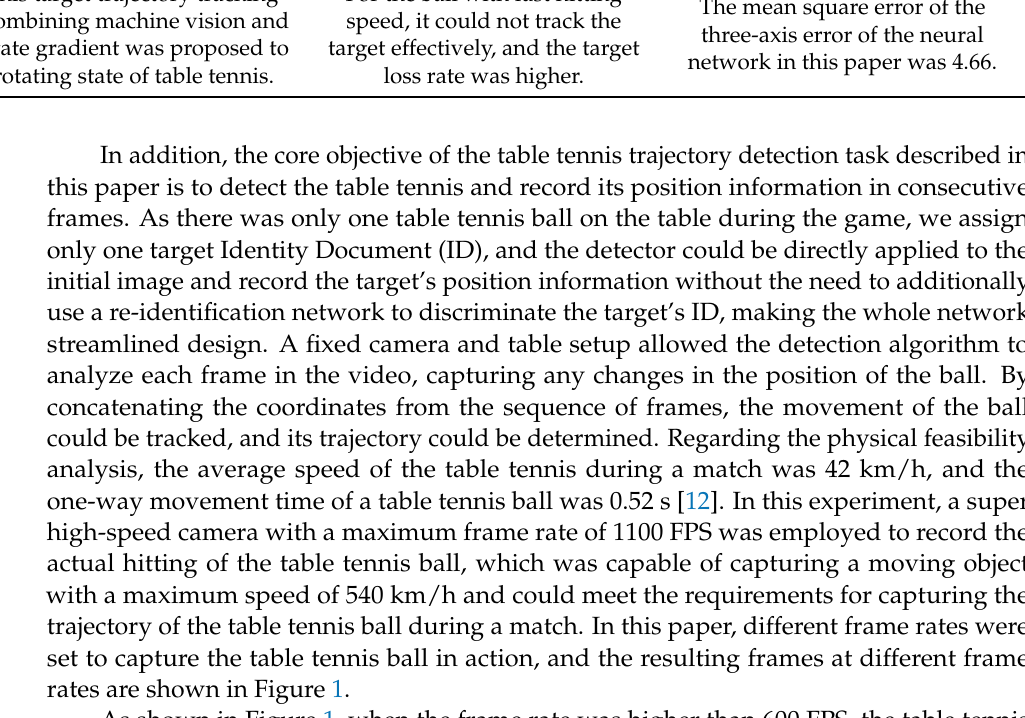
A table tennis target trajectory tracking algorithm combining machine vision